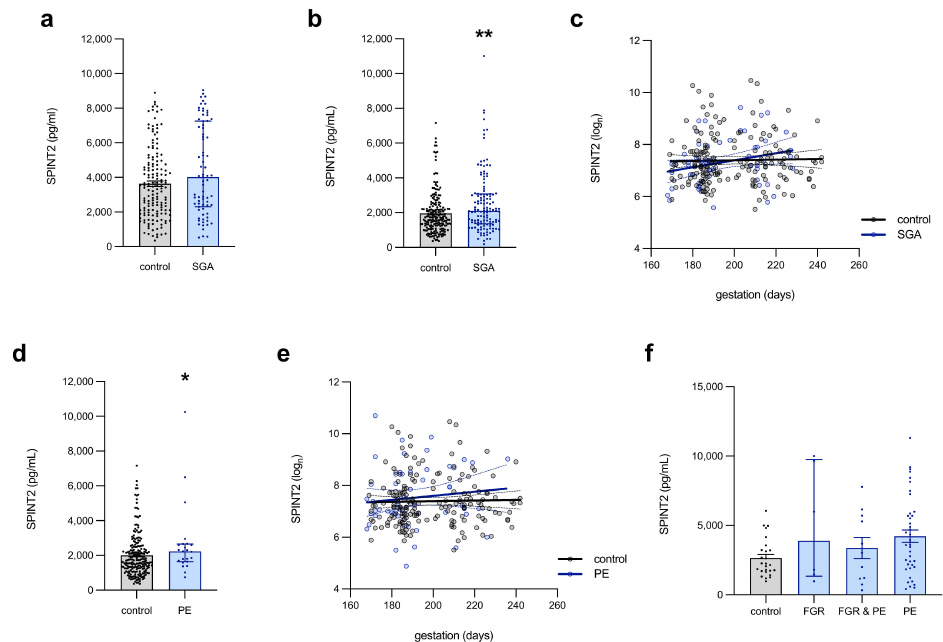
Figure 2. Circulating SPINT2 levels preceding preeclampsia development or birth of a small-for-gestational-age infant. In the blood of women on the day of delivery ( a ), SPINT2 protein expression was increased (approaching statistical significance, p = 0.051) in those who delivered an SGA infant, compared to AGA controls. This association was stronger at 36 weeks’ gestation, in which there was a significant elevation of SPINT2 levels among women who later delivered a small-for-gestational-age (SGA) infant ( b ) as well as in those women who subsequently developed PE ( d ), although the significance of the latter was lost when accounting for outliers. Earlier in the pregnancy, however, at 24–34 weeks, there was no association between circulating SPINT2 and SGA ( c ) nor PE ( e ) cases in samples from women with underlying vascular disease. In this cohort, SPINT2 did not fluctuate across gestation in controls nor PE; however, there was an apparent increase in SPINT2 across gestation in those women destined to birth an SGA infant. In the plasma collected on the day of delivery from women with diagnosed placental insufficiency ( f ), circulating SPINT2 was unchanged in cases, relative to controls. Each data point represents an individual patient sample; data are expressed as median ± IQR; linear regression showing 95% confidence intervals; * p < 0.05, ** p <